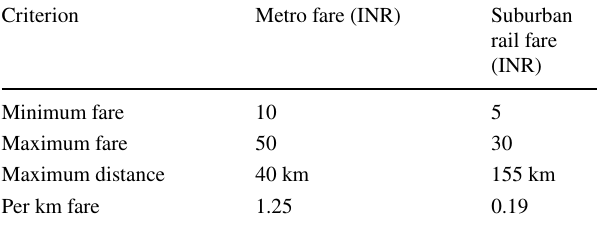
Table 11 Comparison between the metro fare with the suburban fare Criterion Metro fare (INR) Suburban